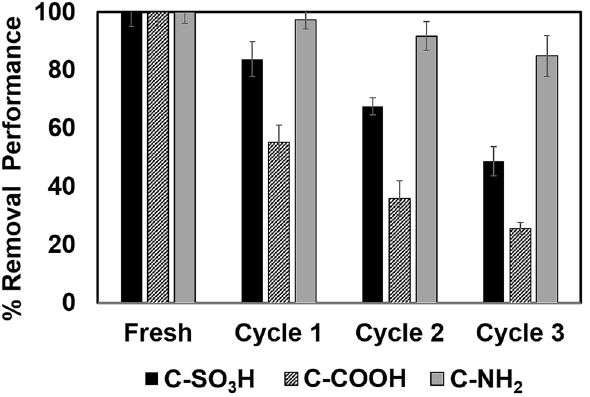
Figure 7. Reusability of the functionalised carbon